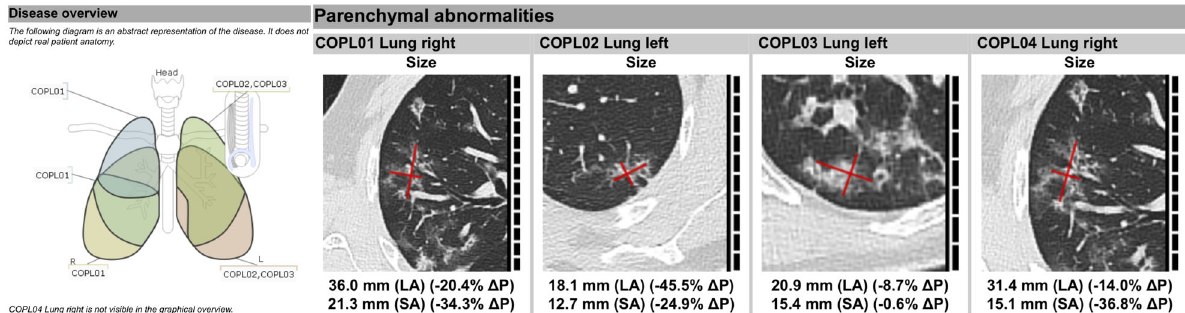
Fig. 4 Overview of locations of major fi ndings on chest CT. Longitudinal overview of documented fi ndings on chest CT examination (here: evaluation after second chest CT in COVID-19 disease course). Decrease in the size (LA long axis, SA short axis) of the imaging fi ndings. These fi ndings are included in an automatically generated case report fi le for a COVID-19-positive patient and study data